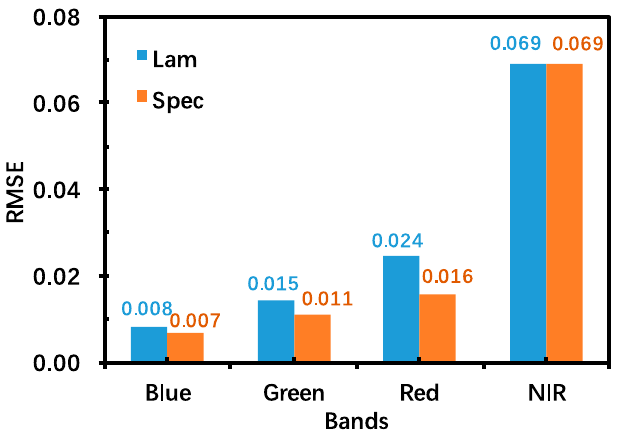
Figure 3. The RMSEs between field-measured and modeled BRF at blue, green, red and NIR bands. “Lam” represents the RMSE calculated with bi-Lambertian leaves, i.e., leaf specular reflection is neglected, whereas “Spec” denotes that accounting for leaf specular reflection.